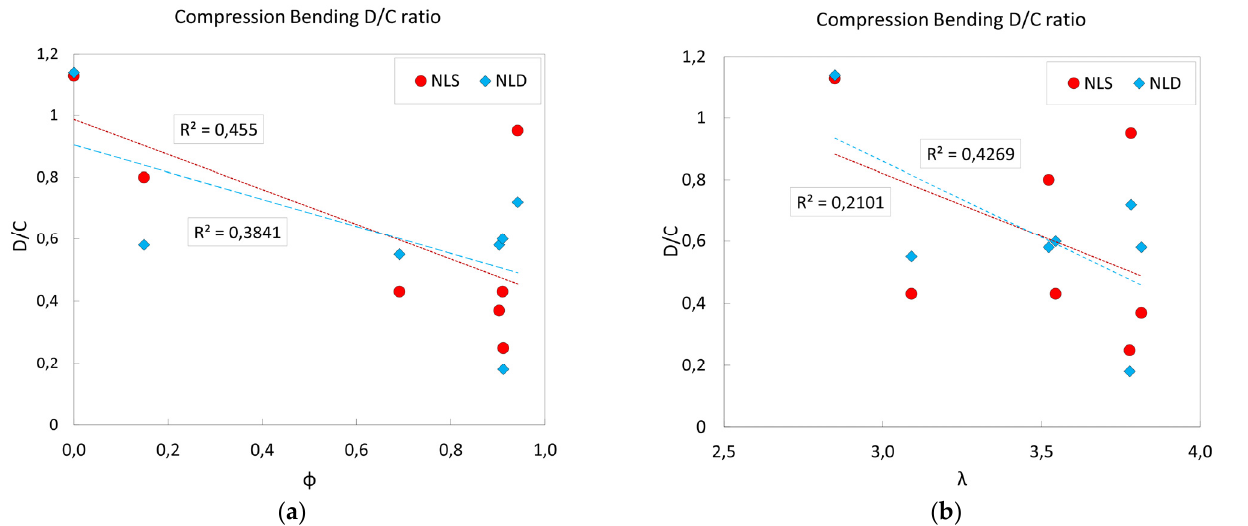
Figure 11. Compression–bending failure distribution for a standard section as a function of the filling ratio ϕ ( a ) and slenderness λ ( b ). Results of the NLS and NLD analyses.